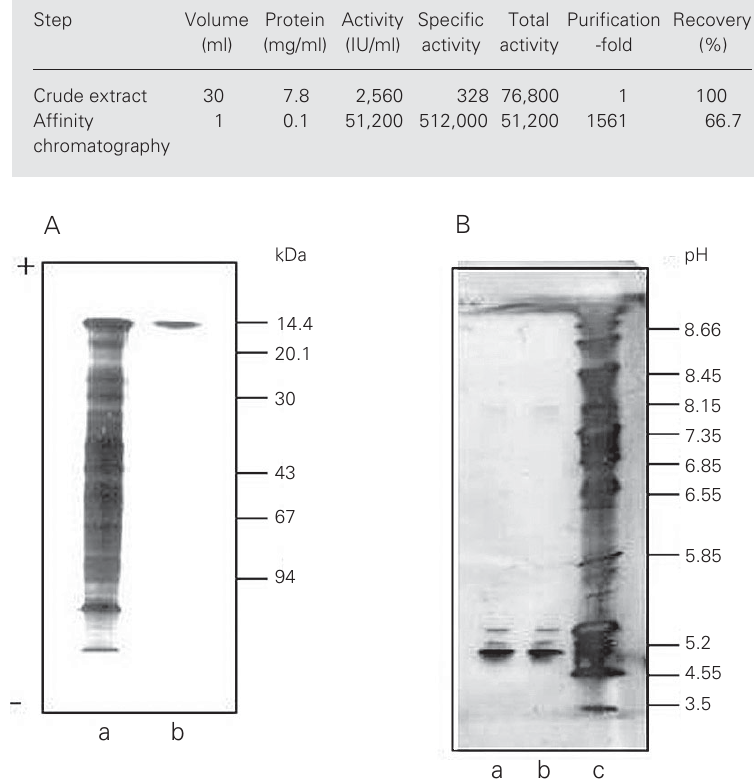
Figure 1. A , SDS-PAGE of cat liver galectin in 12.5% homogenous gel. Lane a , Crude extract of cat liver. Lane b , The galectin purified with asialofetuin-Sepharose. B , Isoelectric focusing pattern of cat liver galectin on Phast gel IEF 3-9. Lanes a and b , The lectin after purification with asialofetuin-Sepharose. Lane c , pI calibration standard